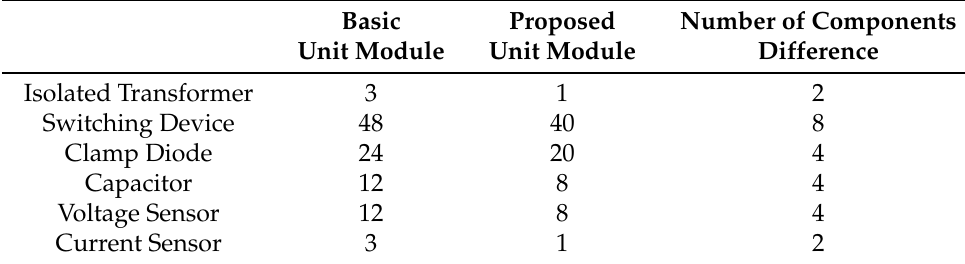
Table 1. Comparison of unit module components of basic structure and proposed structure. Basic Proposed Number of Components Unit Module Unit